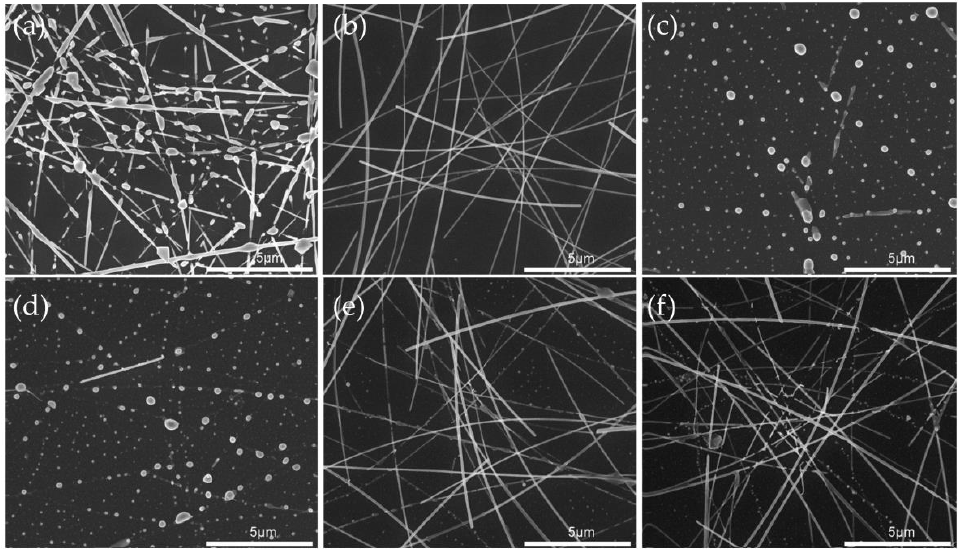
Figure 4. SEM images of films with different deposition time after heat treatment at different temperature: ( a ) pure AgNWs at 200 °C and AgNW – Al 2 O 3 composite films at ( b ) 200 °C@40 s, ( c ) 300 °C@10 s, ( d ) 300 °C@20 s, ( e ) 300 °C@30 s, and ( f ) 300 °C@40 s.